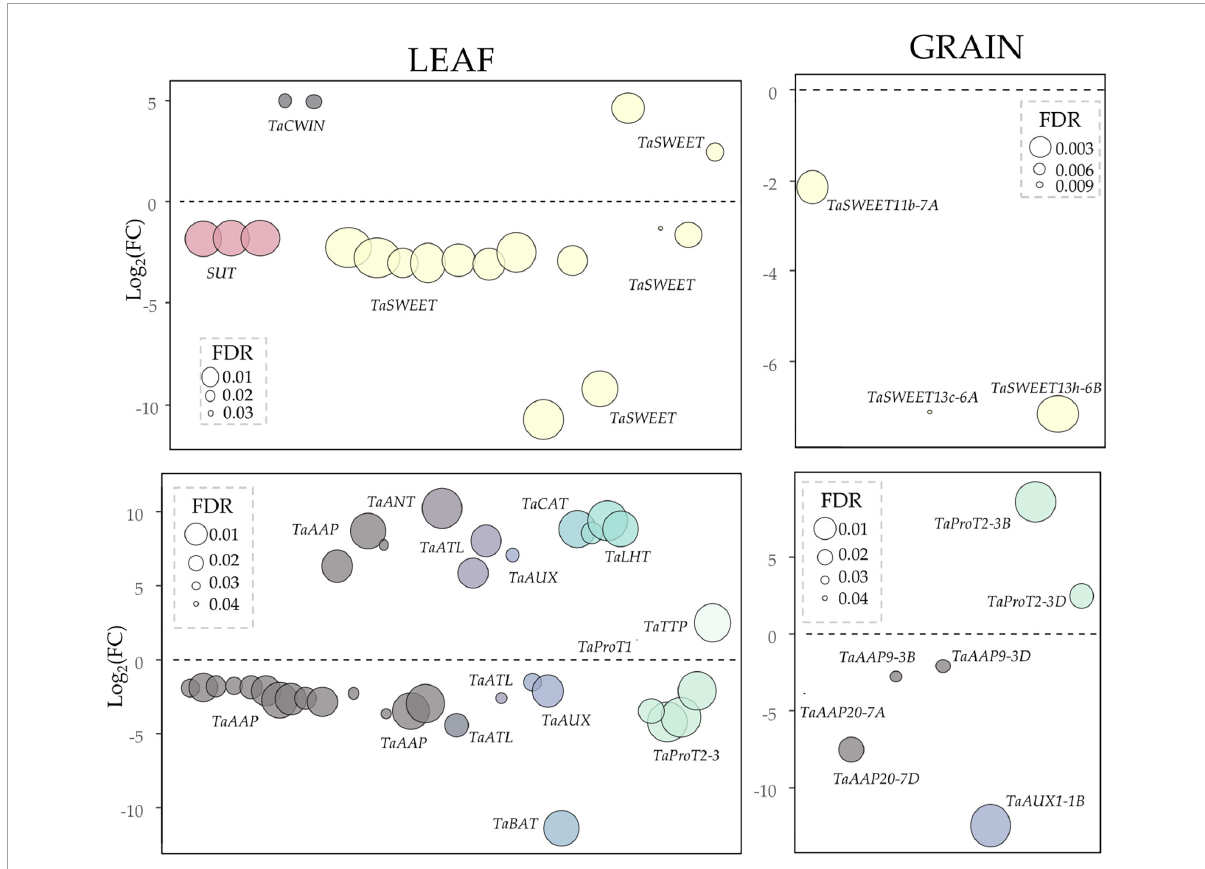
FIGURE8 Sugar transporters (up) and amino acid transporters family (ATF) (down) genes differentially expressed (DE) in the leaf and grain of E82. The Log 2 (FC) is represented, those genes with Log 2 (FC) > 0 are up-regulated in E82, and those with Log 2 (FC) are down-regulated. The size of the dots corresponds to the FDR of each gene. FC, fold-change; FDR, False Discovery